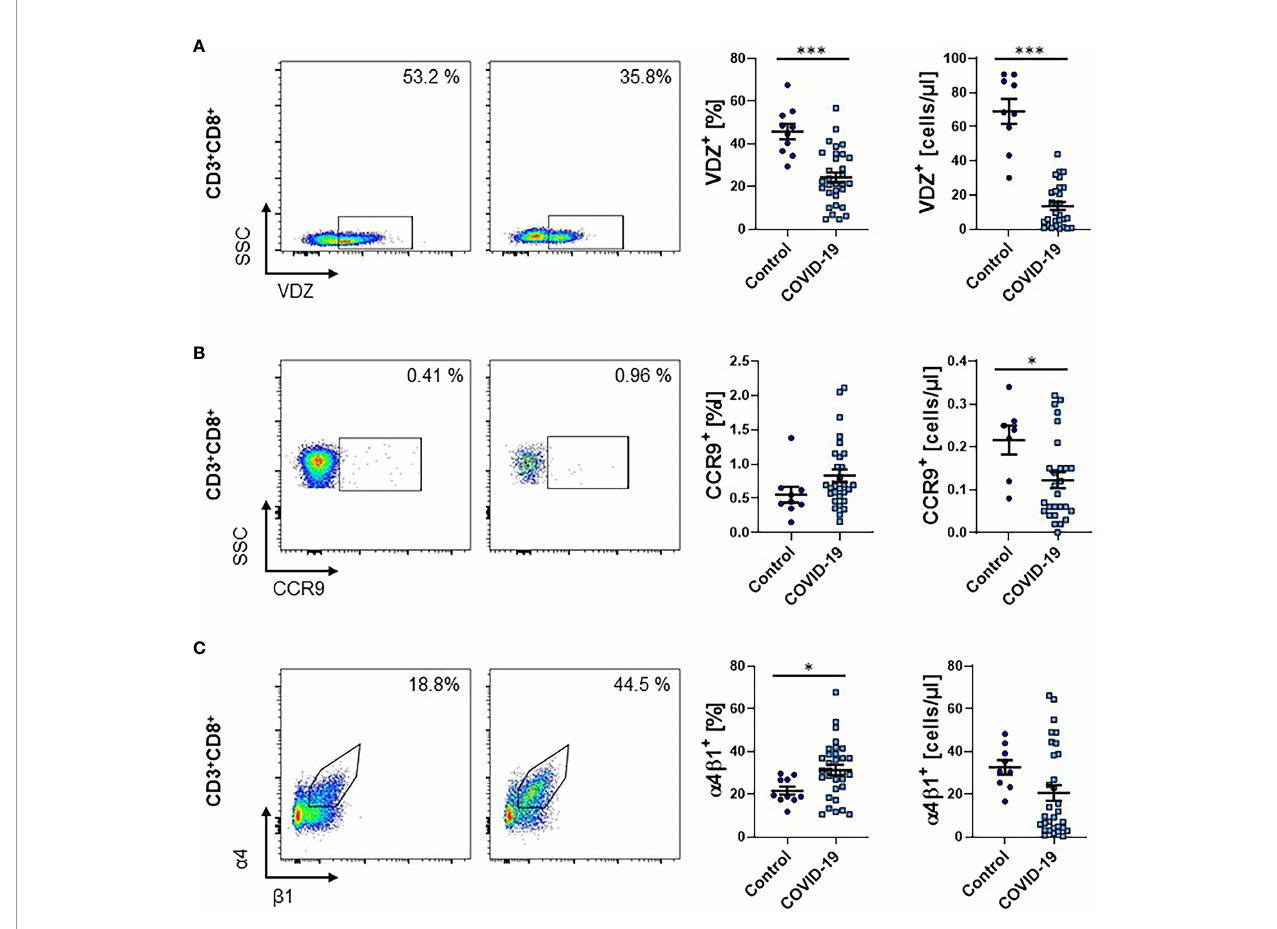
FIGURE 4 | Frequency of gut homing markers on CD3 + CD8 + T cells during COVID-19. (A – C) Flow cytometry of whole blood samples from COVID-19 patients and healthy controls. Representative (left) and quantitative (right) fl ow cytometry of the frequency and absolute cell numbers of a 4 b 7 integrin- (A) , CCR9- (B) and a 4 b 1 integrin- (C) expressing CD3 + CD8 + T cells. VDZ, vedolizumab. Each symbol represents an individual subject, n = 10 – 31 per group. *p < 0.05, ***p <